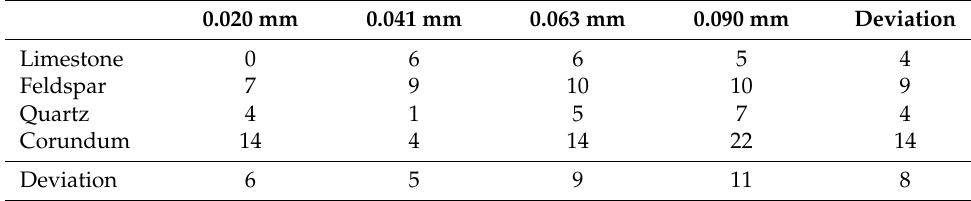
Table 15. Absolute deviation between k VTI (LG) and k THD (LG)